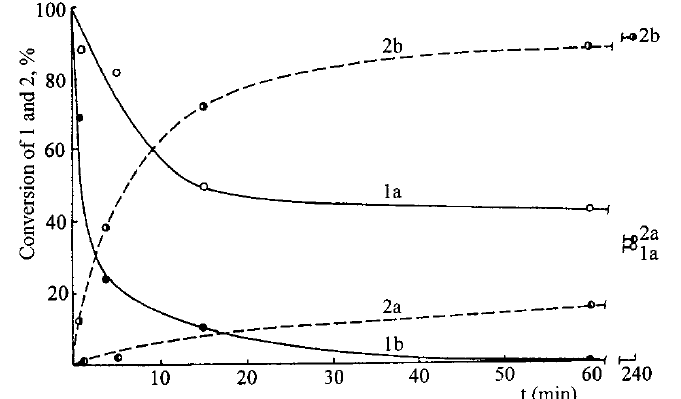
Figure 1. Metalation of ethylbenzene with various superbases. Reaction conditions: BuLi = 0.27 mol L -1 , heptane, 20°C, metalation quenched with methyl iodide; curves: 1a and 1b = ethylbenzene, 2a and 2b = cumene; curves a: [ethylbenzene]/[BuLi]/[ t- BuOK] = 1:1:1; curves b: [ethylbenzene]/[BuLi]/[potassium 3-methyl-3-pentoxide] =